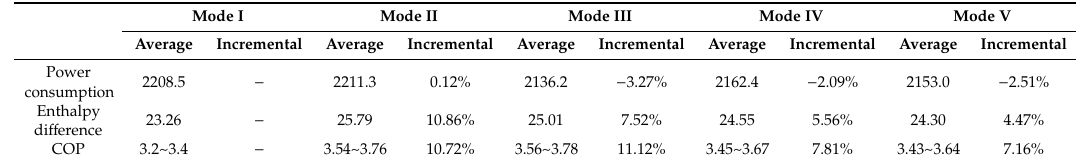
Table 2. COPs of the ASHP unit in di ff erent ultrasonic loading